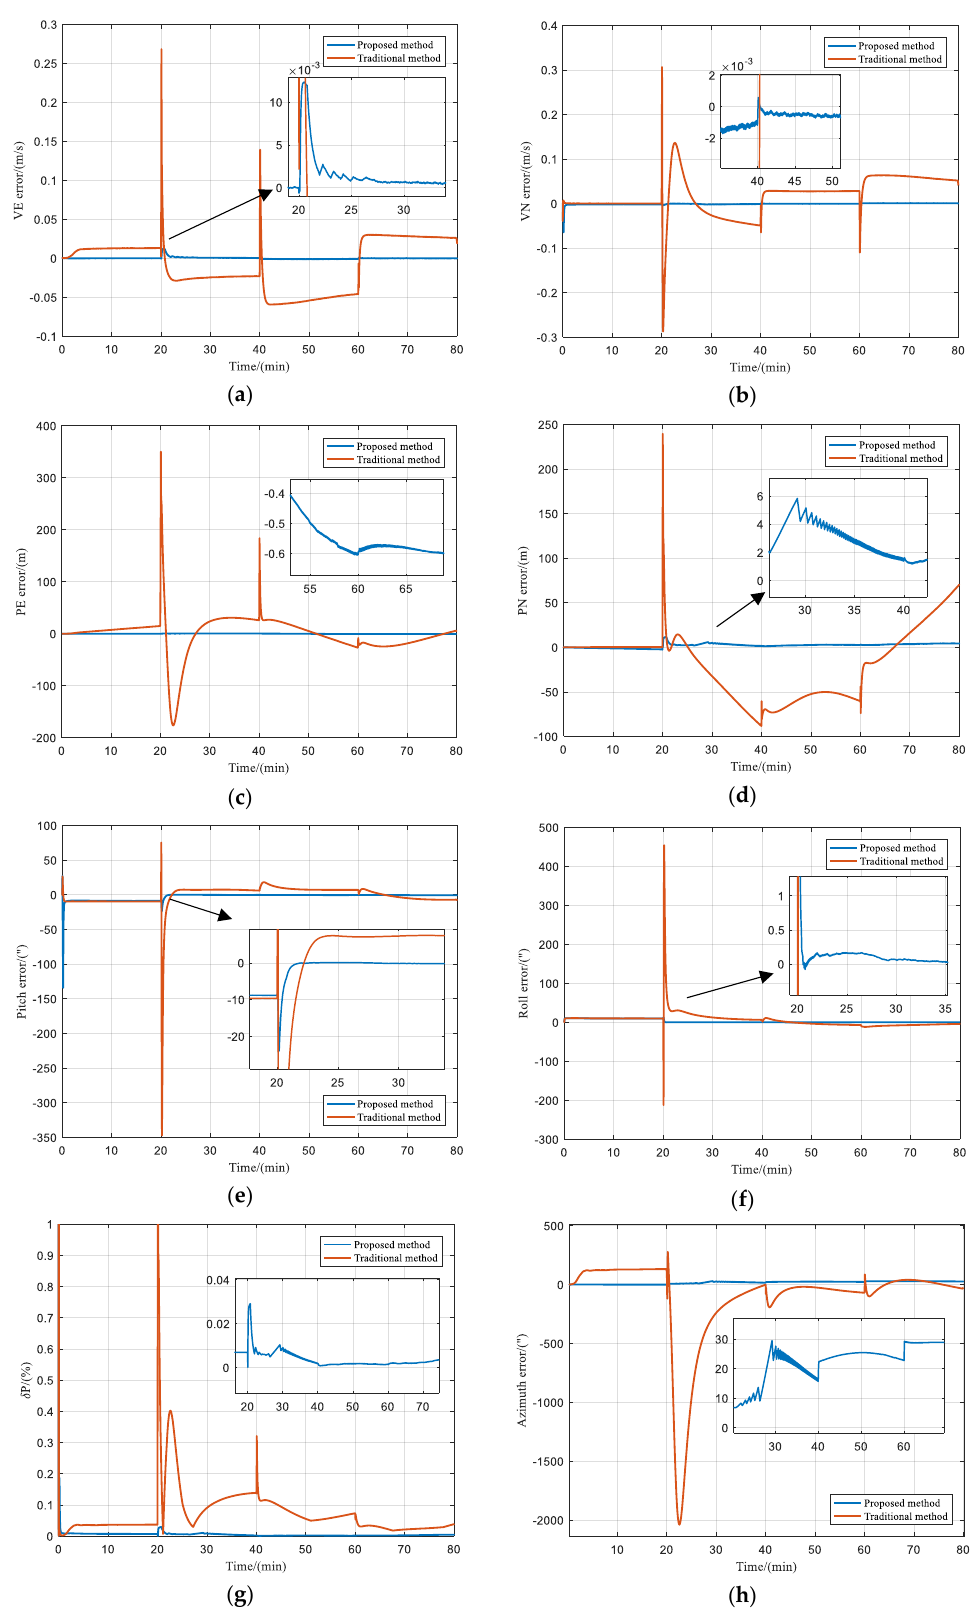
Figure 5. ( a ) V E errors; ( b ) V N errors; ( c ) P E errors; ( d ) P N errors; ( e ) Pitch errors; ( f ) Roll errors; ( g ) The percentage of horizontal position errors; ( h ) Azimuth